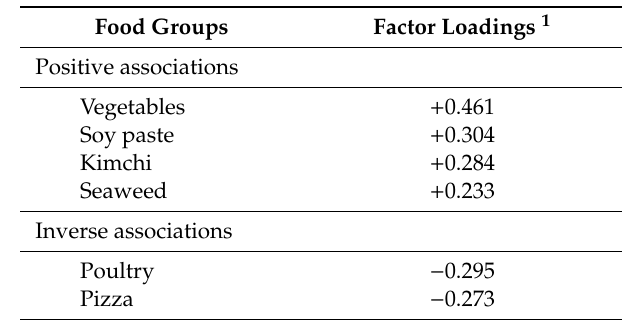
Table 4. Factor loading values of food groups contributing to urinary sodium-to-creatinine ratio through reduced rank regression